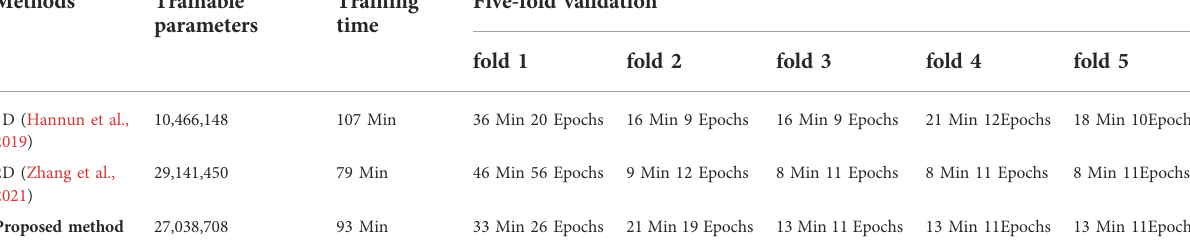
TABLE 8 Comparison of the computational costs of the proposed 3D method VS. 2D and 1D classi fi cation methods. Methods